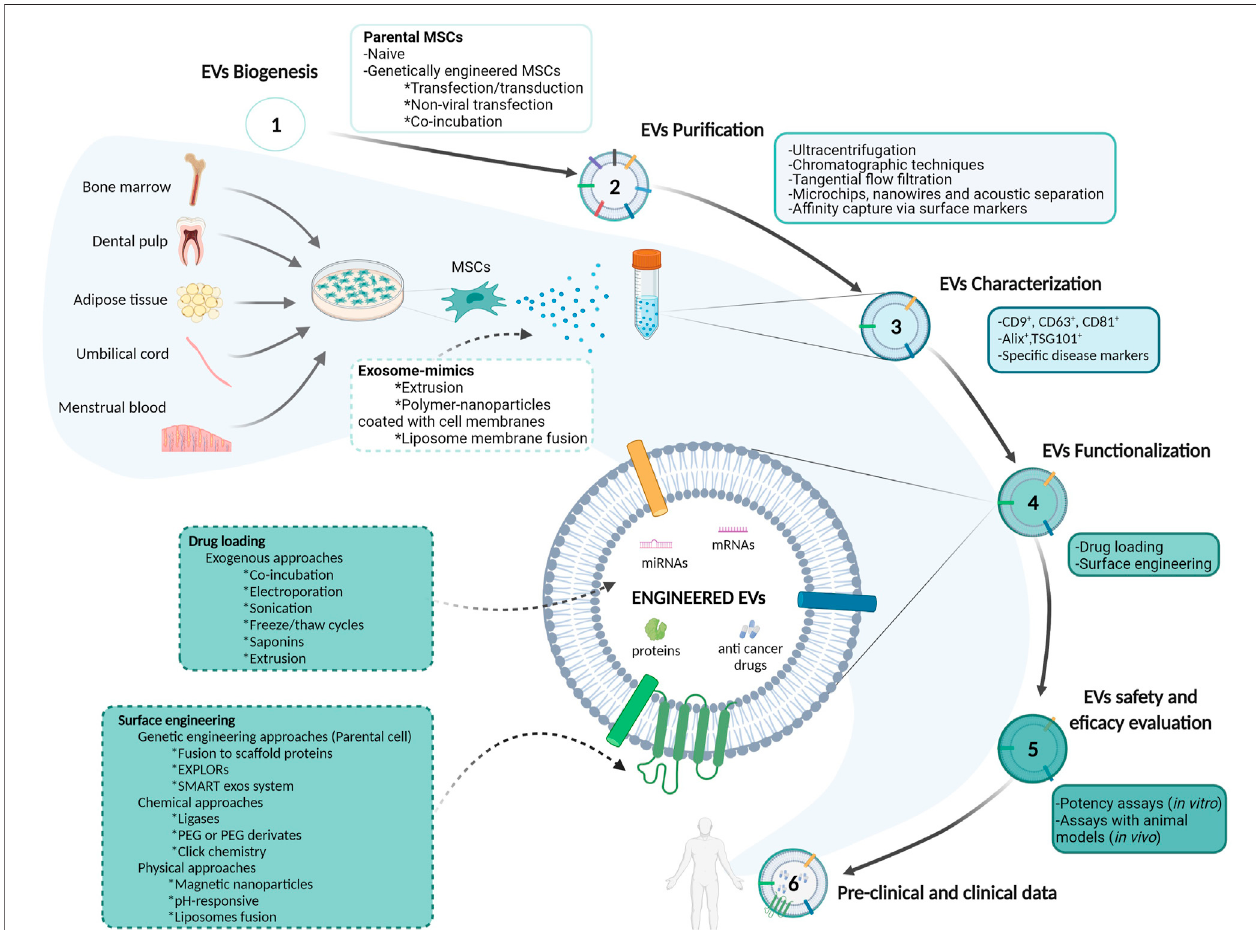
FIGURE 1 | Schematic representation of mesenchymal stem/stromal cells-derived extracellular vesicles isolation, puri fi cation, characterization and evaluation approaches for their utilization as drug delivery systems in cancer therapy. Abbreviations: Alix: apoptosis-linked gene 2 – interacting protein X; EVs: extracellular vesicles; EXPLORs: exosomes for protein loading via optically reversible protein – protein interactions; miRNA: microRNA; mRNA: messenger ribonucleic acid; MSCs: mesenchymal stem/stromal cells; PEG: polyethylene glycol; TSG101: tumor susceptibility gene 101 protein.